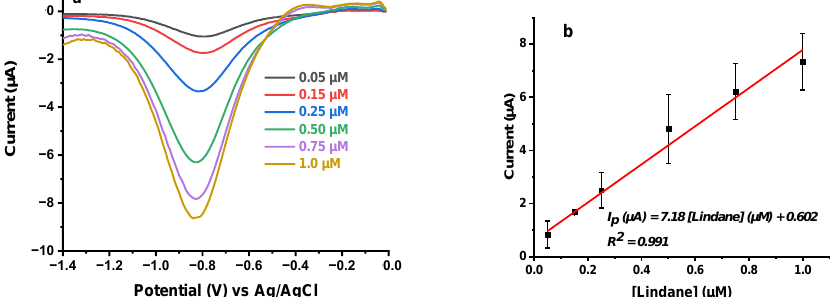
Figure 5. Calibration curve of lindane in 0.2 M KCl using ( a ) square wave voltammetry and ( b ) plot of extracted peak current against lindane concentration. SWV conditions: E step = 0.01 V; Amplitude = 0.1 V; Frequency = 15.0 Hz.